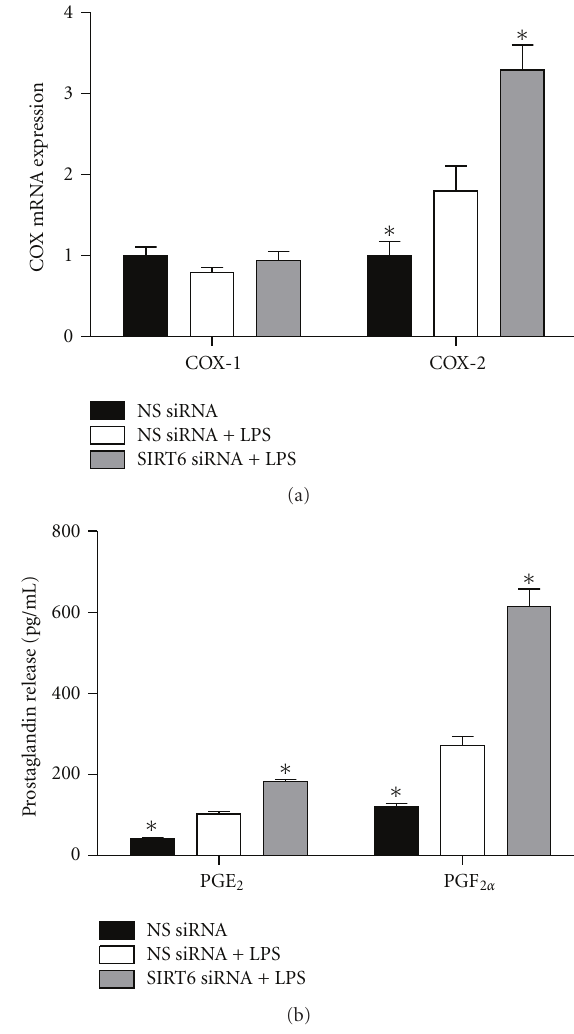
Figure 3: E ff ect of SIRT6 knockdown on proinflammatory cyto- kines. HUVECs were transfected with 50 nM SIRT6 or NS siRNA for 72 h followed by 10 μ g/mL LPS for 24 h ( n = 6). (a) IL-6 and IL- 8 concentration in the conditioned media was assayed using ELISA. (b) IL-1 β , IL-6, and IL-8 mRNA expression was quantified by qRT- PCR. Each bar represents the mean ± SEM. ∗ P < 0 . 05 versus NS siRNA + LPS.